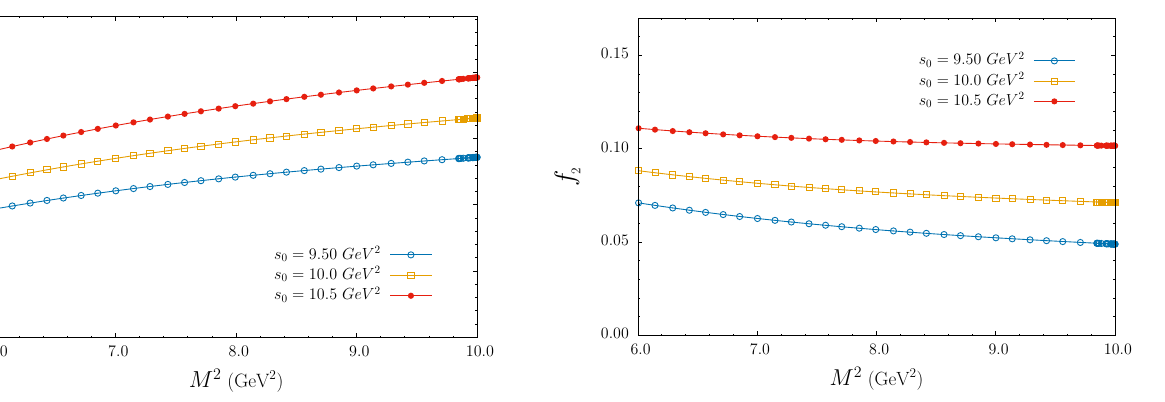
Fig. 3 The dependency of f 2 ( GeV − 1 ) on M 2 at fixed values of s 0 for